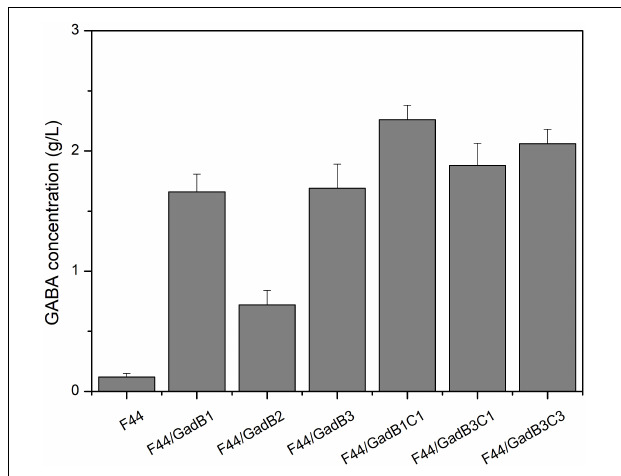
FIGURE 1 | Comparison of GABA production obtained at 24 h by batch cultivation of the original strain F44 and the engineered strains.